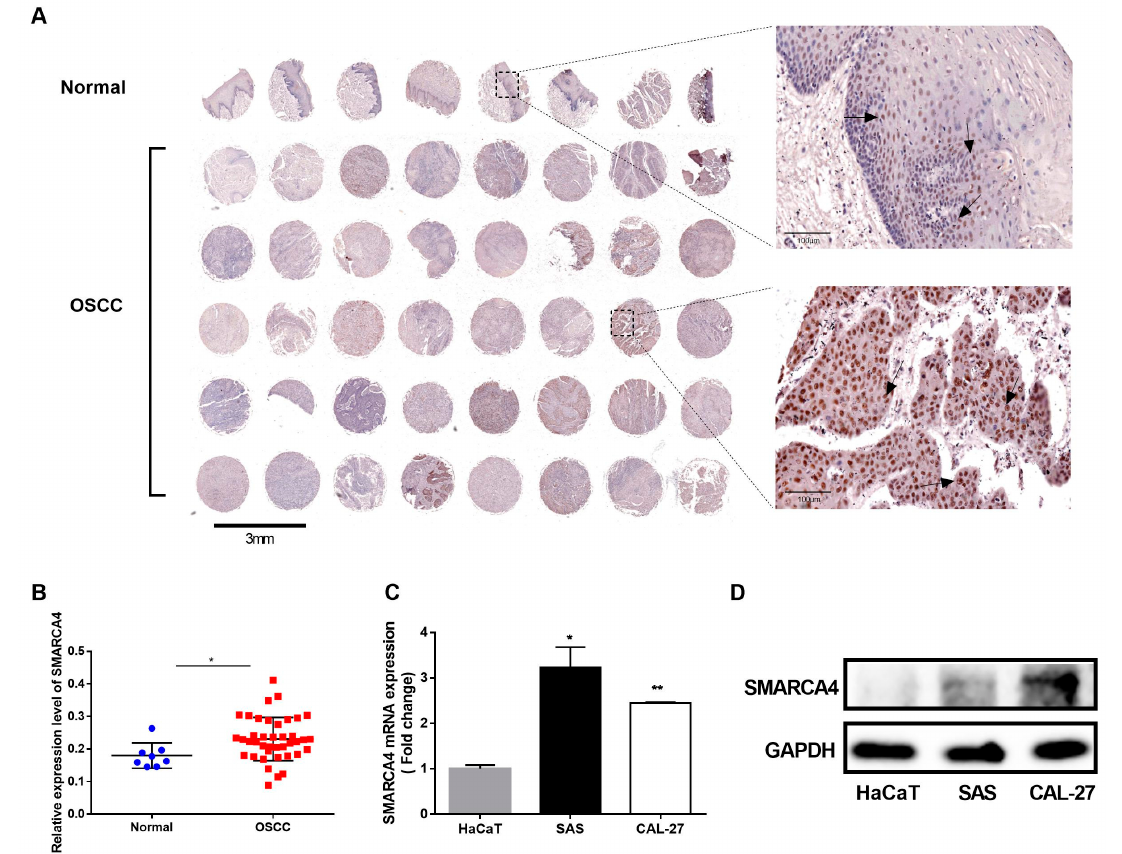
Figure 1. The expression of SMARCA4 is upregulated in OSCC. ( A , B ) A tissue microarray of human OSCC and normal tissues was analyzed by IHC staining using the Image ProPlus software (version1 1.48). ( C ) Comparison of SMARCA4 mRNA expression levels in OSCC cell lines (SAS, CAL-27) with that in HaCat cells by qRT-PCR analysis. Data are expressed as the mean ± SEM from triplicates experiments. * p < 0.05, ** p < 0.01. ( D ) Comparison of SMARCA4 protein expression levels in OSCC cell lines (SAS, CAL-27) with that in HaCat cells by western blot